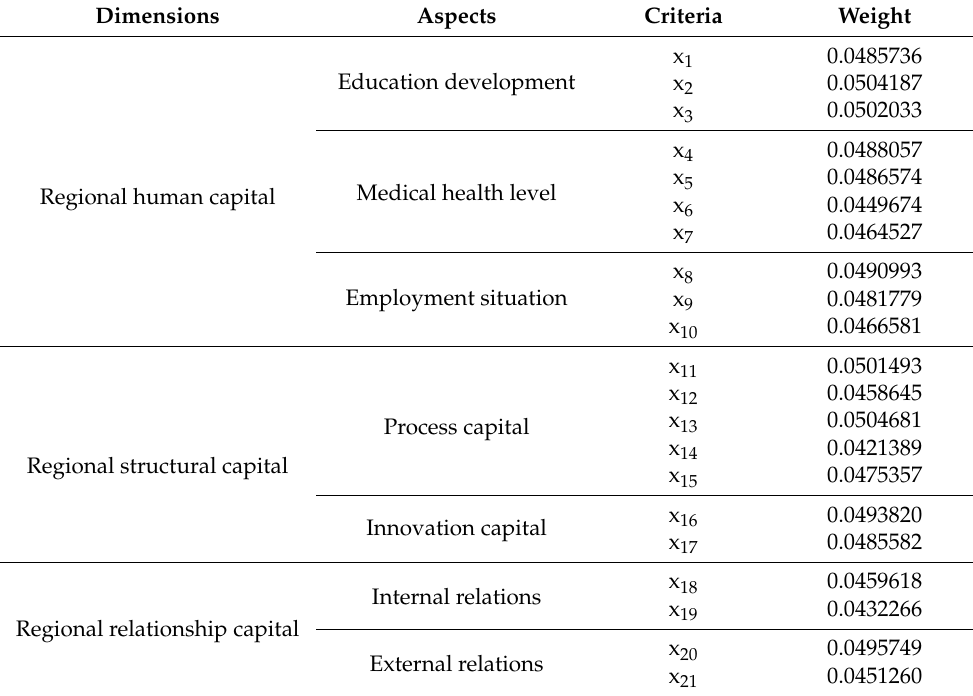
Table 7. The weight of criteria influencing